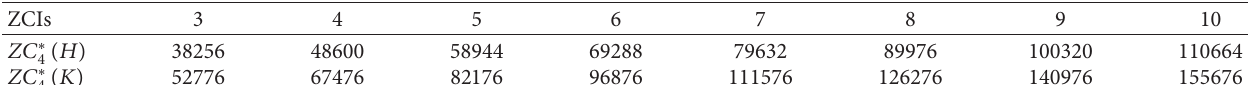
for H and K networks on dimensions 3 ≤ n ≤ 10. 4